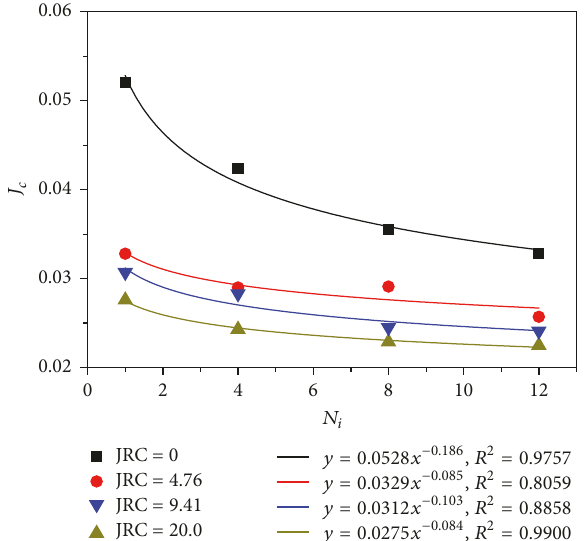
Figure 18: Relationships between 𝐽 𝑐 and 𝑁 𝑖 based on the data replotted from Liu et al. ([36], Figure 6